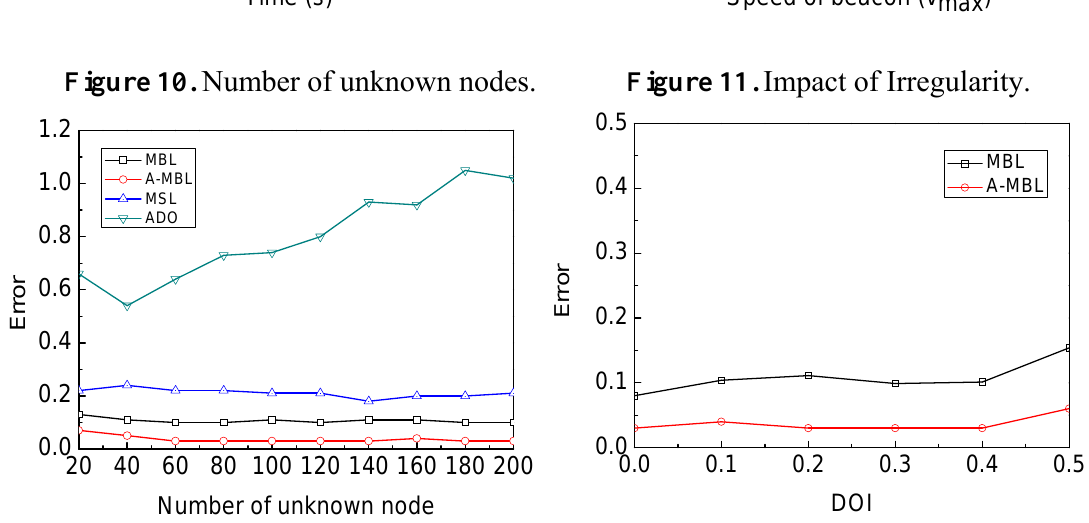
Figure 8. Comparison of accuracy. Figure 9. Speed of beacon.